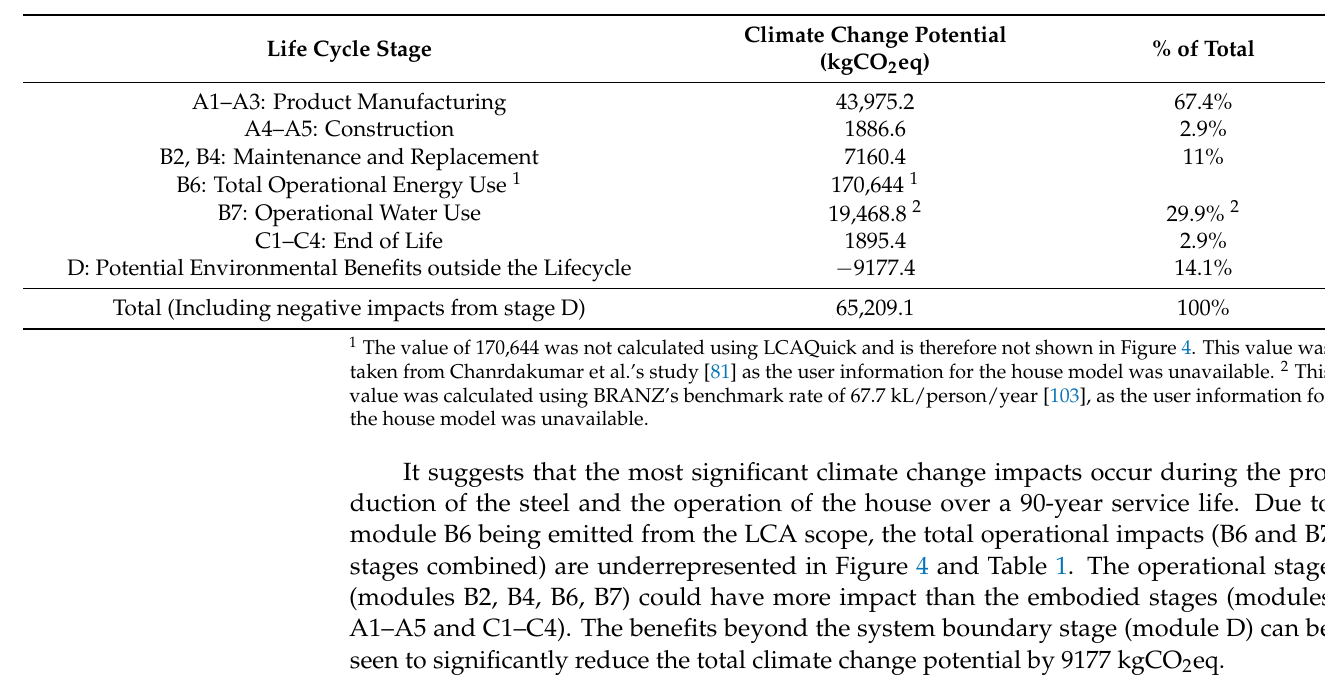
Figure 4. Schematic diagram of absolute climate change potential for each life cycle stage. Table 1. Absolute climate change potential (kgCO 2 eq) for each life cycle stage